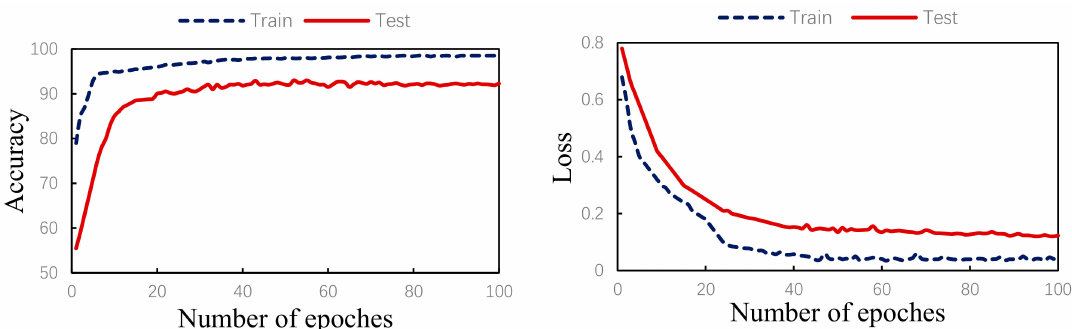
Figure 9. Training / test accuracy and loss curves.